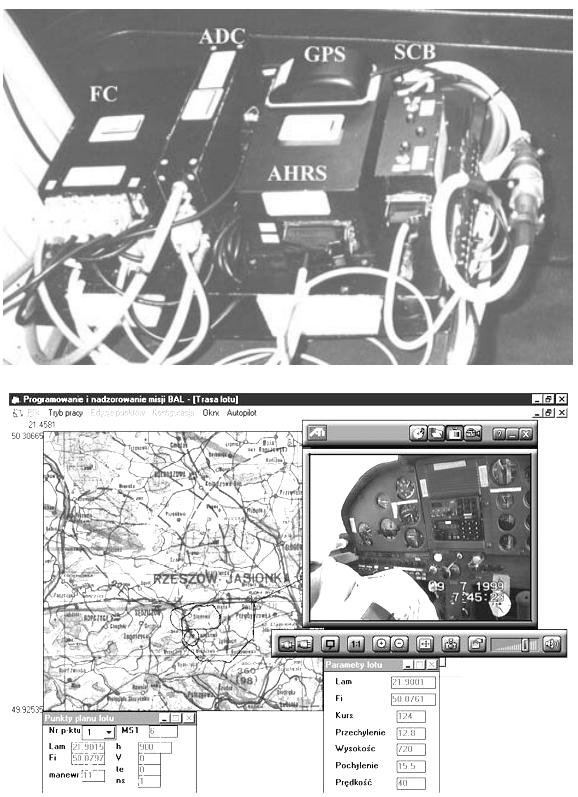
Fig 1. Modules of APC mounted in aircraft (upper); a view of the software at the ground station (lower)